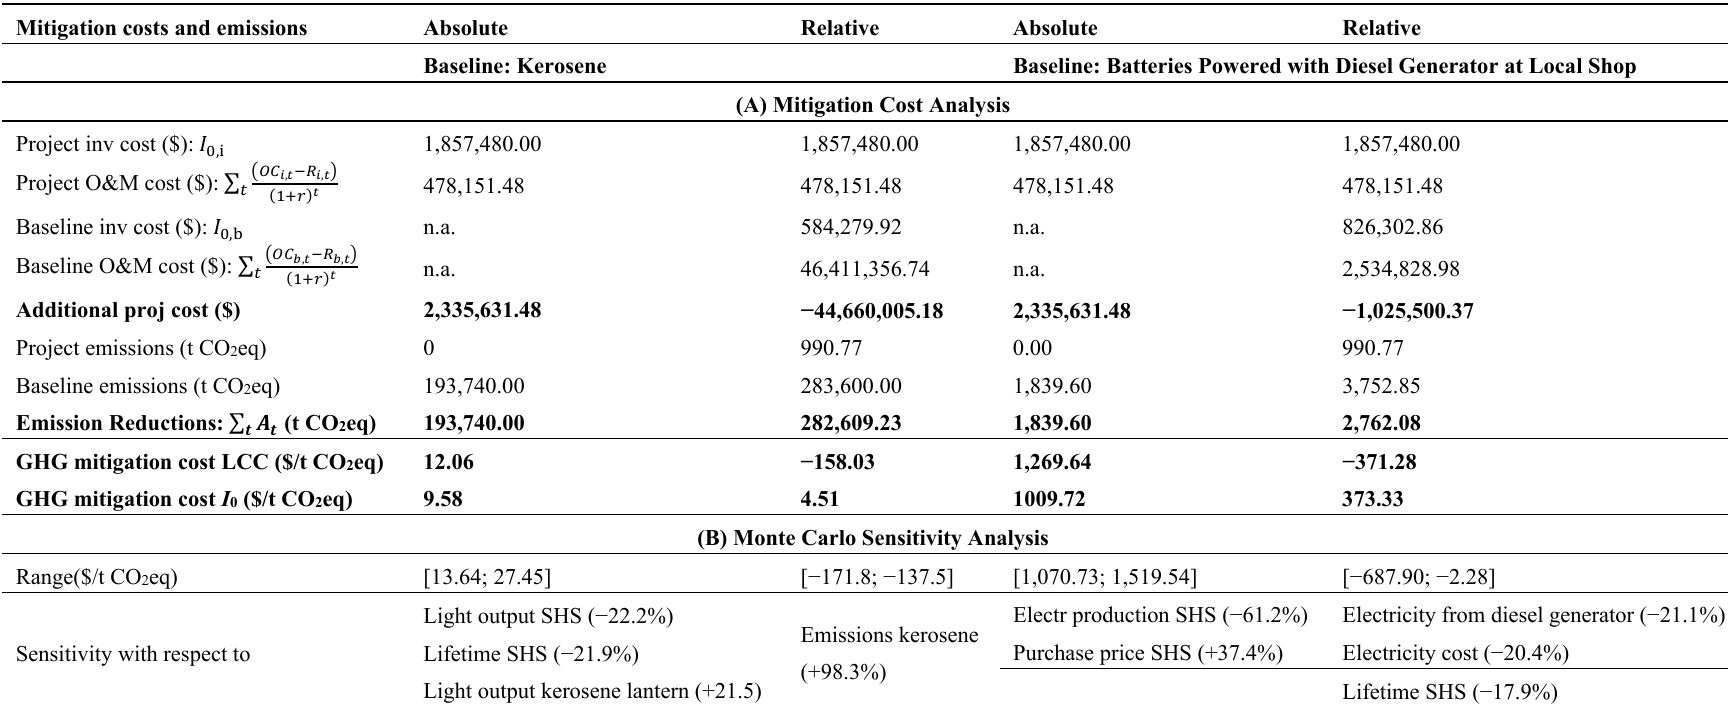
Table 2. GHG mitigation costs of solar home systems vs . (i) kerosene or (ii) batteries powered with diesel generators. Mitigation costs and emissions Absolute Relative Absolute